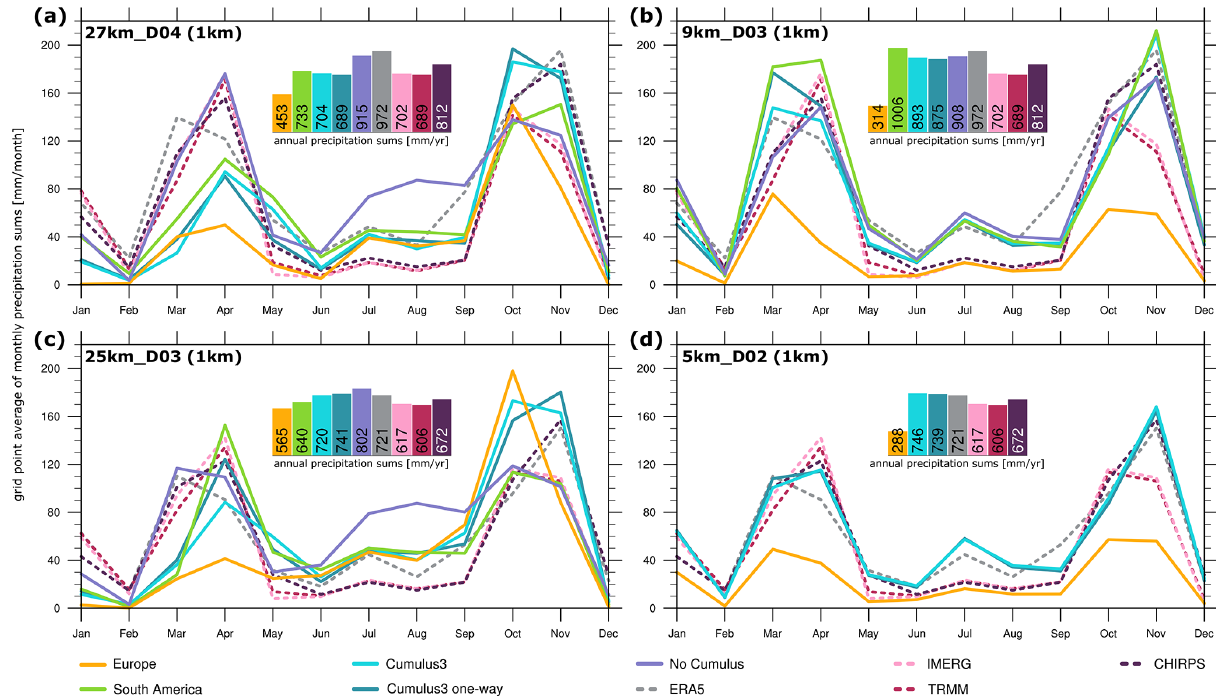
Figure 5. Grid point averages of monthly precipitation sums in millimetres per month for the year 2008 in the innermost domain (1km) for each of the tested setups: 27km (a) , 9km (b) , 25km (c) , and 5km (d) . The five tested parameterization options are included, along with the driving reanalysis ERA5 and the three observational gridded data sets (IMERG, TRMM, and CHIRPS). All the gridded data sets are plotted with different shades of pink, while ERA5 is coloured in grey. The inset of a bar plot in each panel indicates the grid point average annual precipitation sum in millimetres per year for each parameterization option and gridded data